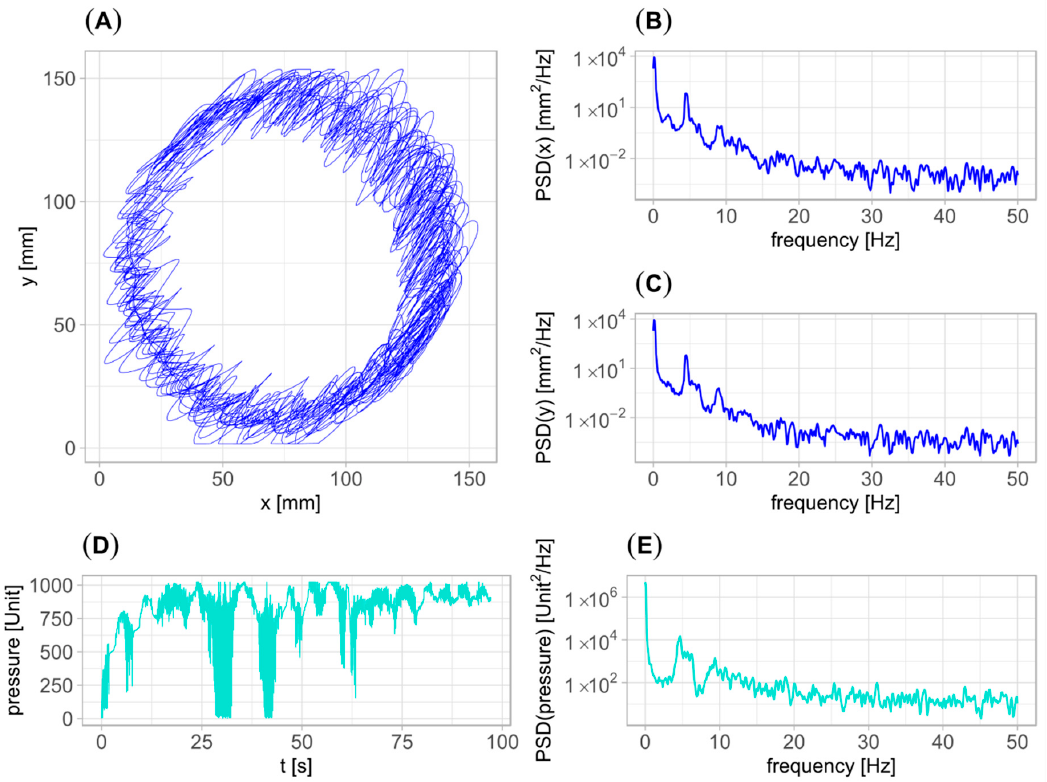
Figure 1. Exemplary signals acquired from the patient having a severe tremor. ( A ) two-dimensional pen trajectory; ( B , C ) power spectral densities (PSDs) of x and y pen trajectory coordinates, respectively; ( D ) pen pressure. ( E ) PSD of pen pressure.